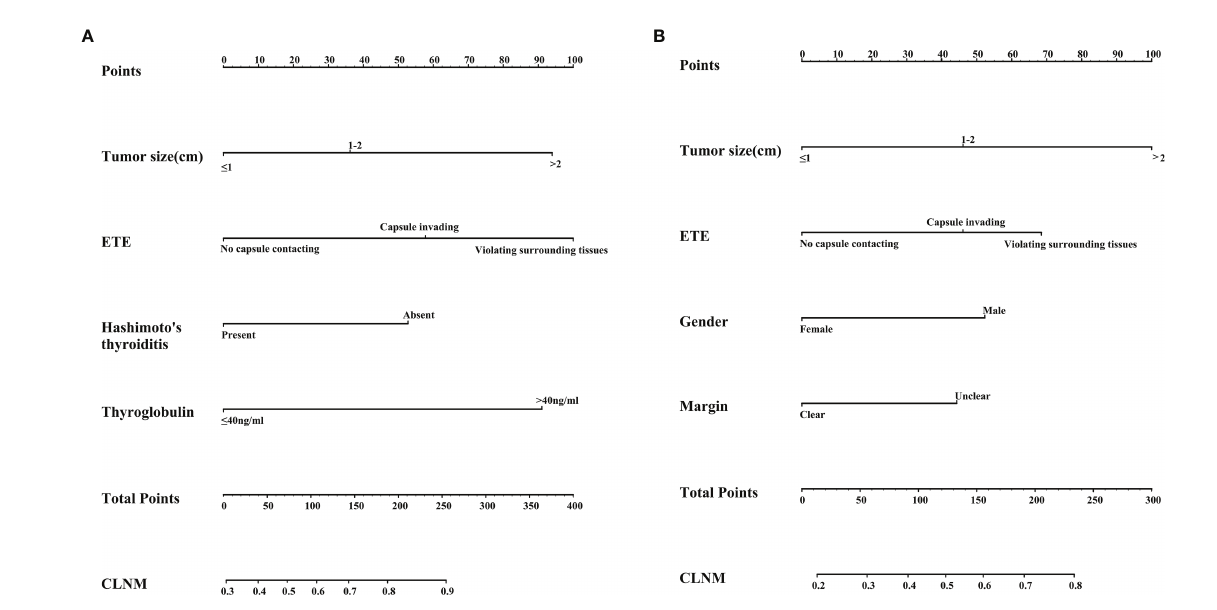
FIGURE 3 | (A) Nomogram for predicting CLNM in the subgroup with age<45 years; (B) Nomogram for predicting CLNM in the subgroup with age ≥ 45 years.